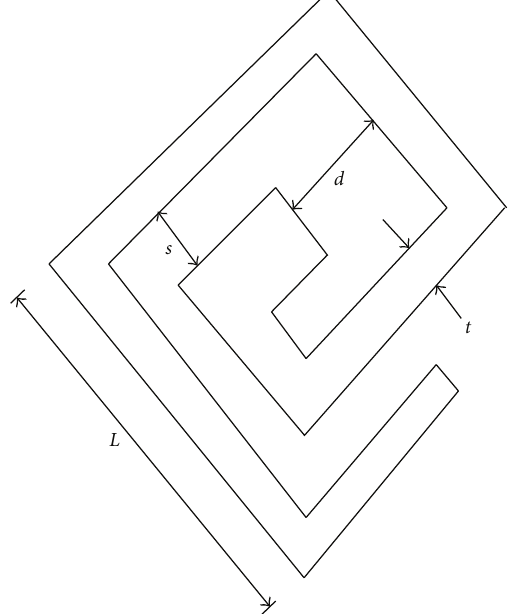
Figure 3: Tilted square spiral slot